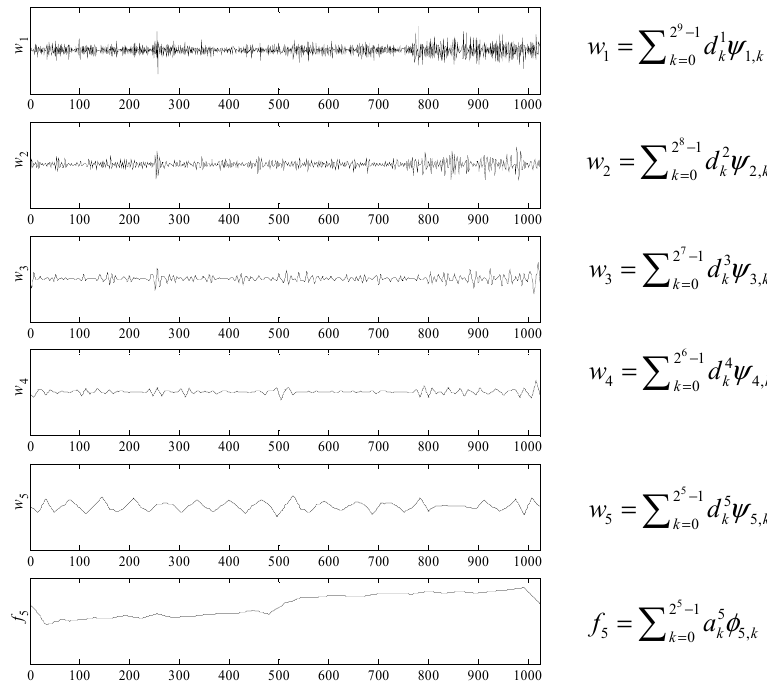
Figure 5. The signal in Figure 2 decomposed into its coarser version at scale j = 5 plus all the details lost across the scales ranging from j = 1 to j = 5. The filter used here is the Daubechies’s compactly supported filter with 3 vanishing moments (A wavelet has p vanishing moments if for 0 ≤ k < p . This is an important property in the fields of signal and image compression, since it can induce a higher number of low magnitude detail coefficients, if the signal does have local regularity